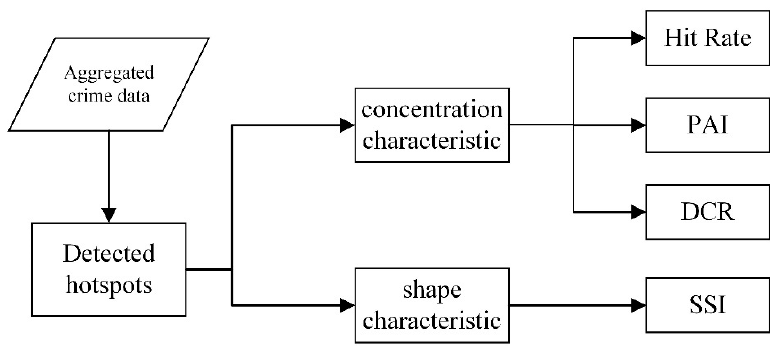
Figure 1. Crime hotspot evaluation framework.